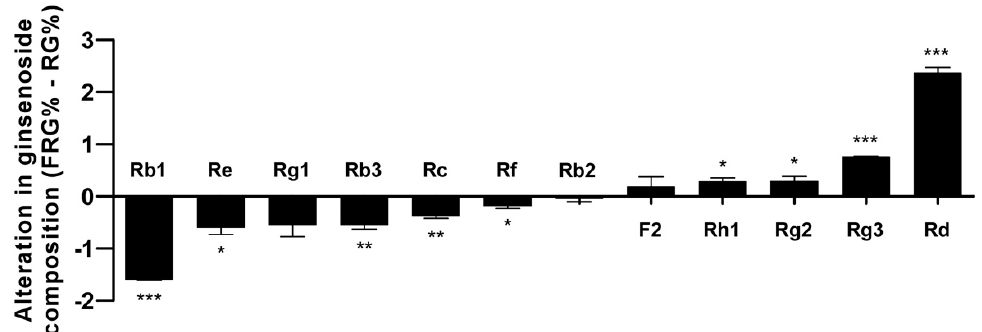
Figure 8. Alteration in relative composition of ginsenosides in red ginseng (RG) and FRG. The relative proportion (%) of ginsenoside contents was analyzed. The differences are shown by subtracting the % value of RG from % value of FRG. Positive values mean an increase in relative content in FRG compared to RG and negative values mean a decrease in relative content in FRG compared to RG. * p < 0.05; ** p < 0.01; *** p < 0.001, significant differences in relative content between FRG and RG ( n = 3).